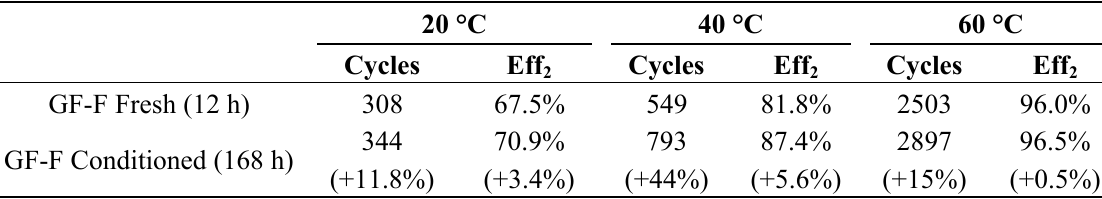
Table 1. Number of cycles before cut-off voltage is reached and corresponding efficiencies ), according to Equation (3) ( Q (Eff 2 TFSI-0.1 LiTFSI/Li Li/0.9 Pyr 14